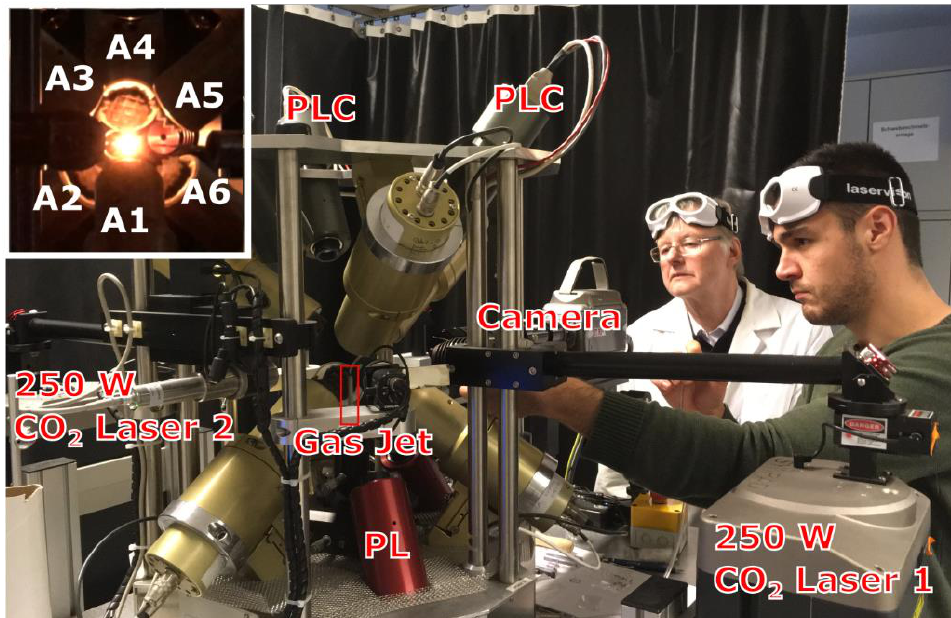
Figure 1. Operation of the aero-acoustic levitator at RWTH Aachen. J.N. is positioning the bead using an air pick above the gas jet for levitation. Inset: the sample bead heated with the dual laser beam, A1–A6 are frequency matched 22.2 kHz acoustic transducers controlled with input from positioning lasers and cameras (labeled PL and PLC, respectively).